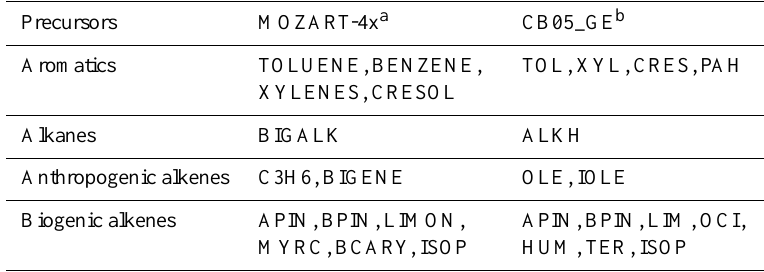
Table 1. Gas-phase organic aerosol precursors in the two mechanisms. Precursors MOZART-4x a CB05_GE b Aromatics TOLUENE, BENZENE, TOL, XYL, CRES, PAH XYLENES, CRESOL Alkanes BIGALK ALKH Anthropogenic alkenes C3H6, BIGENE OLE, IOLE Biogenic alkenes APIN, BPIN, LIMON, APIN, BPIN, LIM, MYRC, BCARY, ISOP